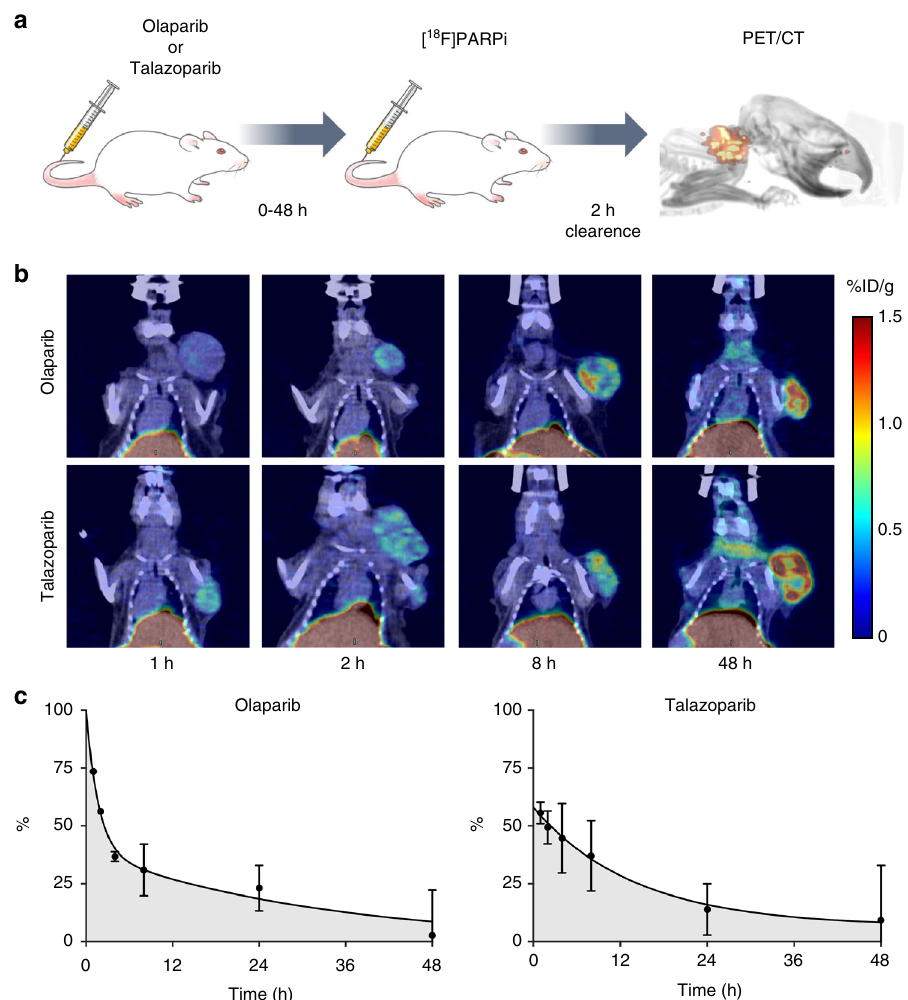
Fig. 8 In vivo kinetics of different PARP inhibitors. a JHU-LX48 SCLC PDX bearing mice ( n = 3/group, 15 groups, 45 mice total) were injected (i.v.) fi rst with olaparib (50 mg/kg) or talazoparib (0.3 mg/kg). Mice were injected (i.v.) with 200 – 300 µ Ci of [ 18 F]PARPi 1, 2, 4, 8, 24, or 48 h later, and imaged via PET/ CT 2 h post [ 18 F]PARPi injection. b Representative coronal slices from 4 different time points after olaparib (left) and talazoparib (right) administration. c Quanti fi cation of PET images for tumor uptake at each of 6 different time points represented as a percentage of blocked signal. Error bars represent the